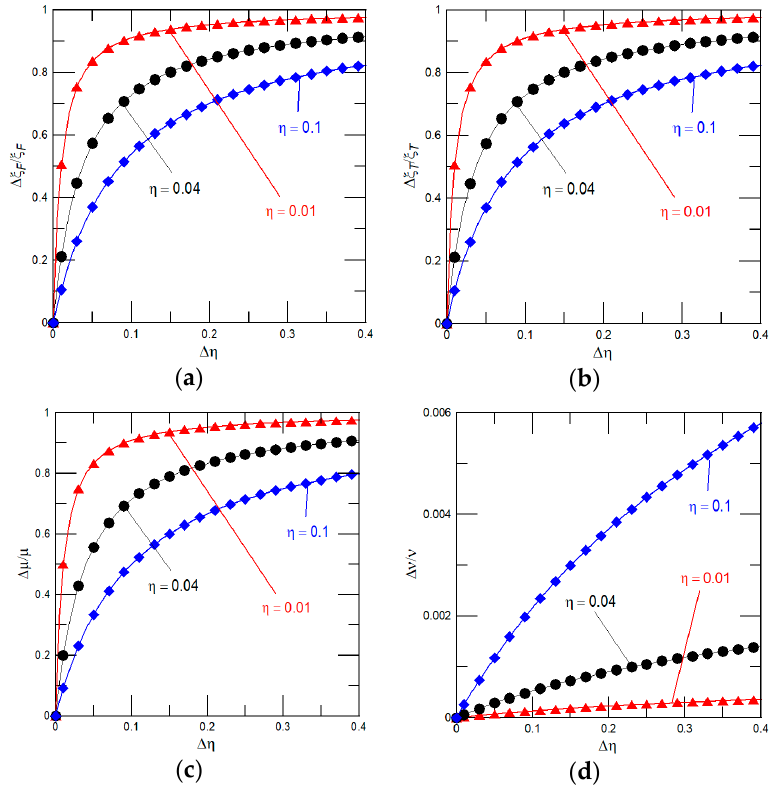
Figure 4. The achievable relative sensitivity of ( a ) the Young’s modulus (Equation (24)); ( b ) the shear modulus (Equation (24)); ( c ) density (Equation (23)); and ( d ) the Poisson’s ratio (Equation (25)) of gold film of η = 0.01, 0.04, and 0.1 coated on the silicon substrate with dimensions 300 µ m ( L ), 30 µ m ( W ), and 1 µ m ( T 1